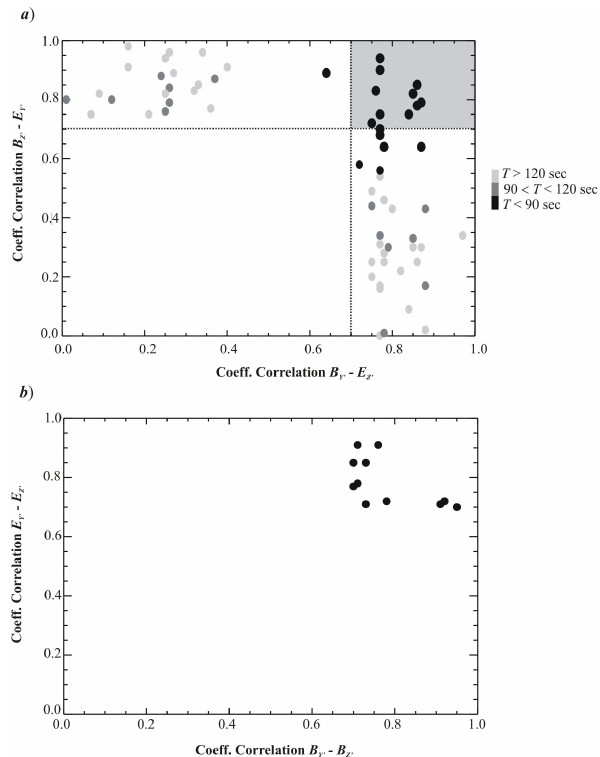
Fig. 9. (a) Scatterplot of the coefficients of correlation between δBY 0 and δEZ 0 versus the values of the correlation between δBZ 0 and δEY 0 , for those PSBL crossings, where high ( > 0.7) correla- tions between drift velocities of high- and low-energy ions were de- tected. The color of each circle represents the period of wavy pertur- bation of the magnetic flux tubes observed in a given PSBL cross- ing according to the grey scale shown at the right part of this figure. (b) Scatterplot of the coefficients of correlation between δEY 0 (t) and δEZ 0 (t + T /4) versus the coefficients of correlation between δBY 0 (t) and δBZ 0 (t + T /4) for the circularly polarized perturba-